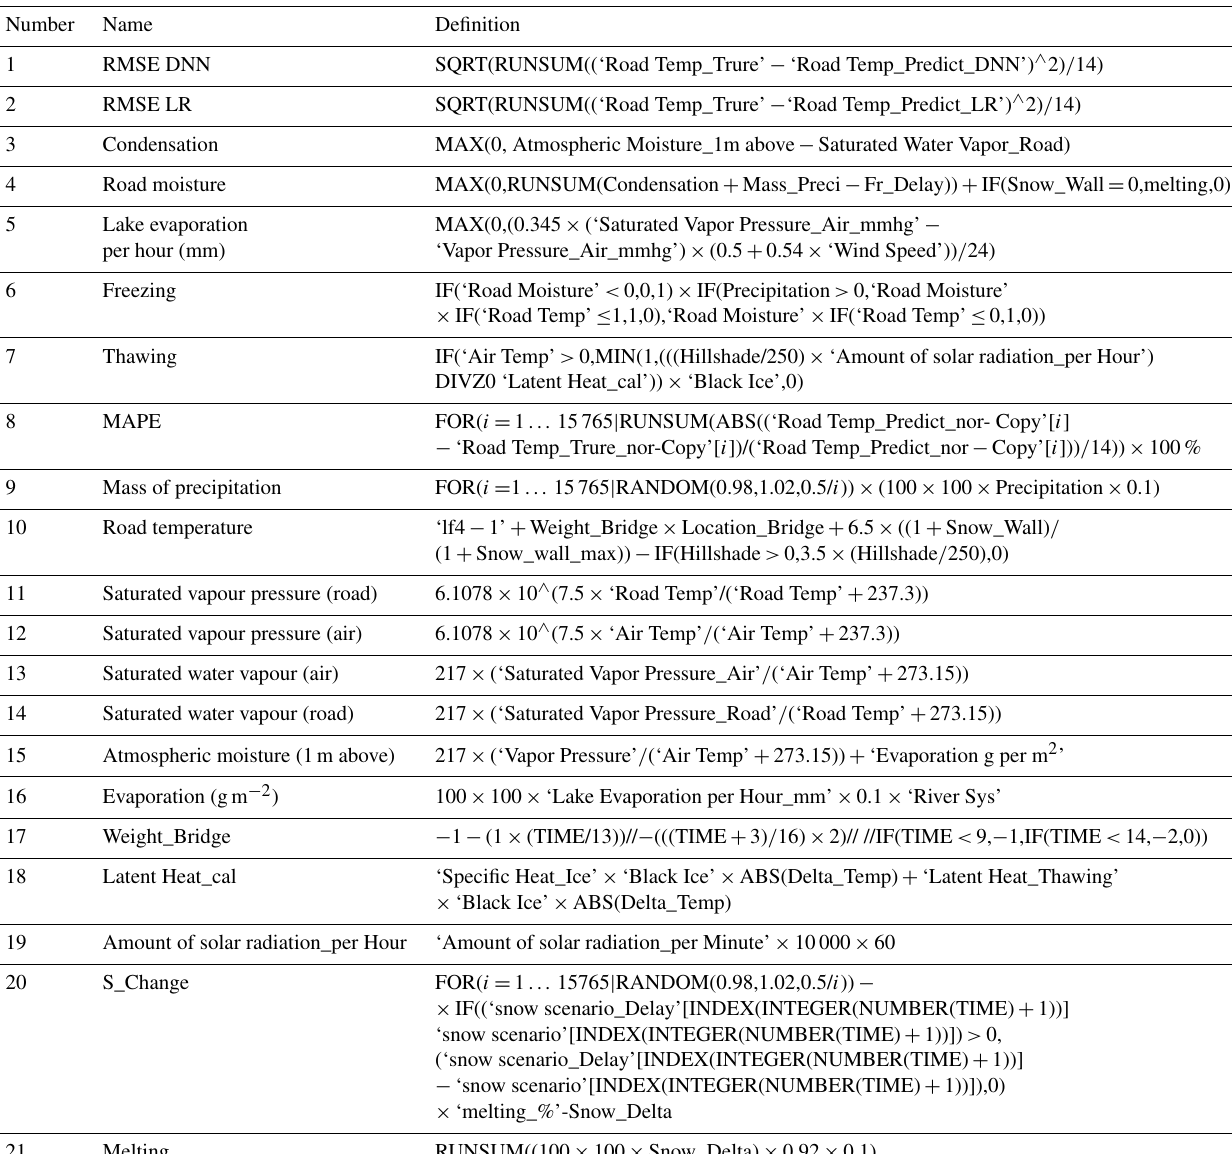
Table A1. The primary definition of a